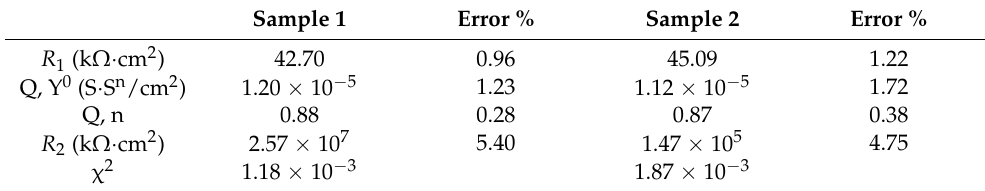
Table 6. Fitted EIS parameters using the equivalent circuit model presented in Figure 8.